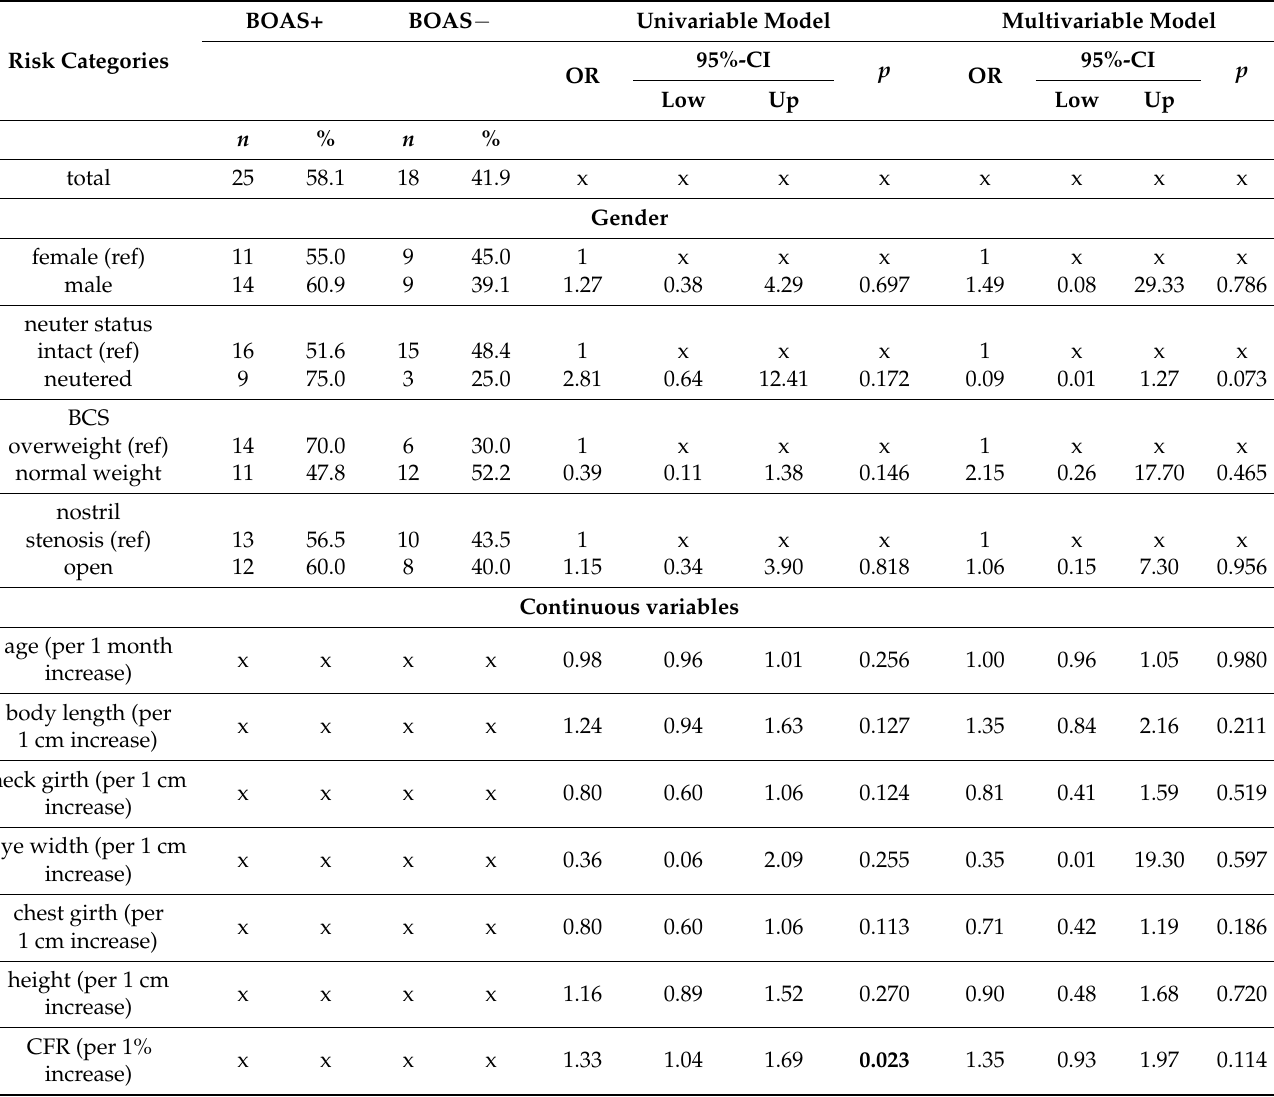
Table 8. Results of univariable and multivariable logistic